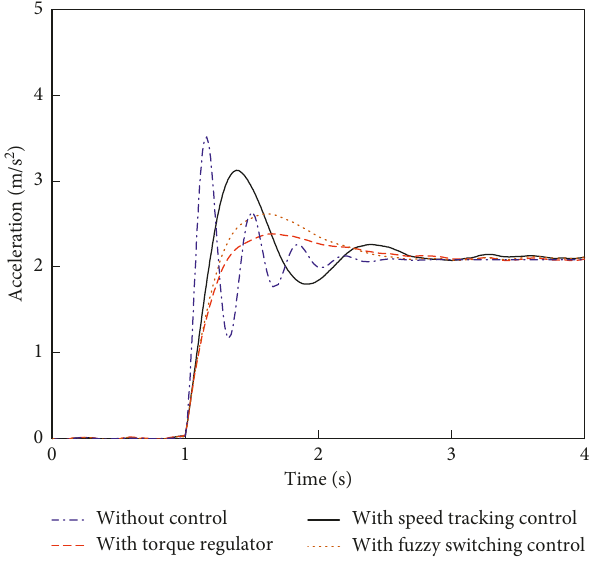
Figure 12: Longitudinal acceleration